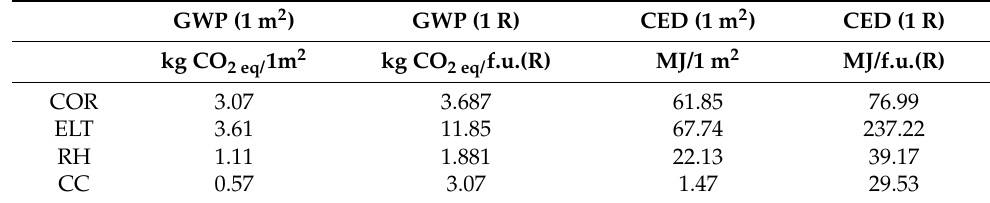
Table 6. GWP (kg CO 2 eq ) and CED (MJ) for 1 m 2 of panel and for R = 1 m 2 K/W